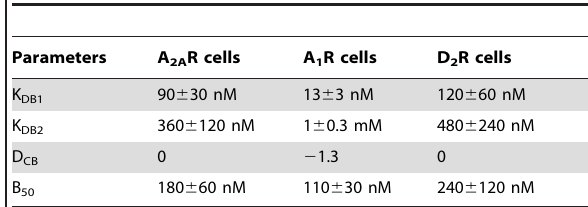
Table 1. Pharmacological parameters for agonist binding to